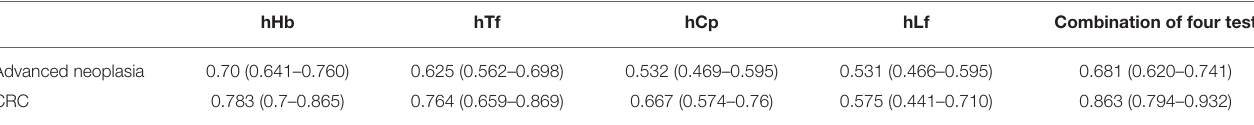
TABLE 4 | AUCs (95%CI) of the four biomarkers of the combo test and their combination for diagnosis of advanced neoplasia and